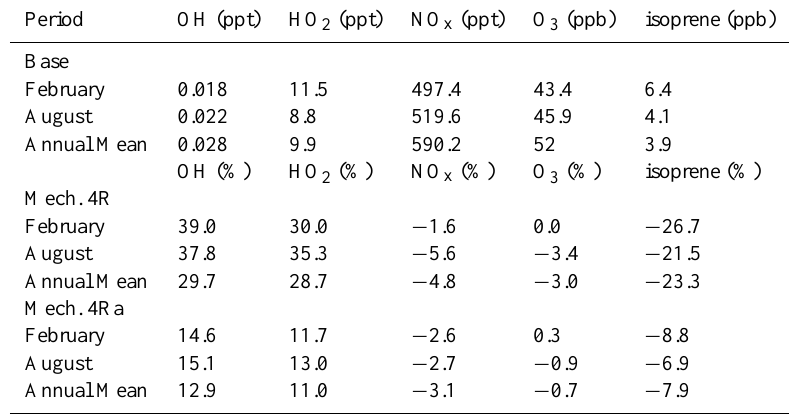
Table 2. Mixing ratio and percentage changes from the base case for a selection of species in a 5 ◦ × 5 ◦ ×∼ 1km grid box centred at 2.5 ◦ S and 67.5 ◦ W representative of the Amazon Forest. %=((Sensitivity Run-BASE)/BASE) · 100.